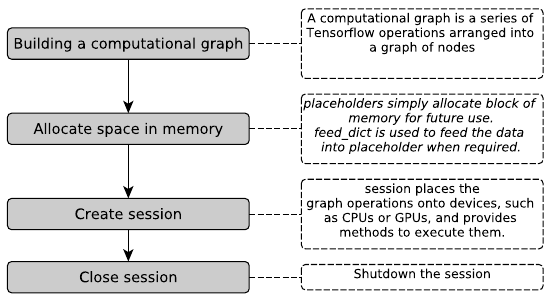
Figure 6. Block diagram a Tensorflow core program storing a value, represents an area whose size changes depend- ing from the resolution of the map. Cells are arranged in rows and columns where rows represent the x-axis and columns y- axis of a Cartesian plane. Stored values in each cell repre- sents continuous data such as altitude or temperature, or cat- egorical data. consider a set of raster maps of fixed size. To formally describe, a raster R with I = { i 1 , i 2 , ..., i m } rows and J = { j 1 , j 2 , ..., j n } columns is a set of fixed locations distributed regularly in space with constant distance between adjacent locations. For every location, we record observations on a fixed set of time stamps, T = { c 1 , c 2 , ..., c t } , which can again be regularly spaced with equal delays between consecu- tive measurements as shown in Figure 7.